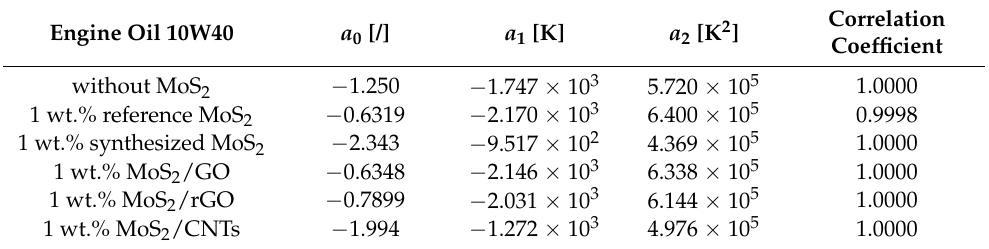
the least square method. Table 3. Polynomial coefficients in Equation (13) for the oil consistency index.